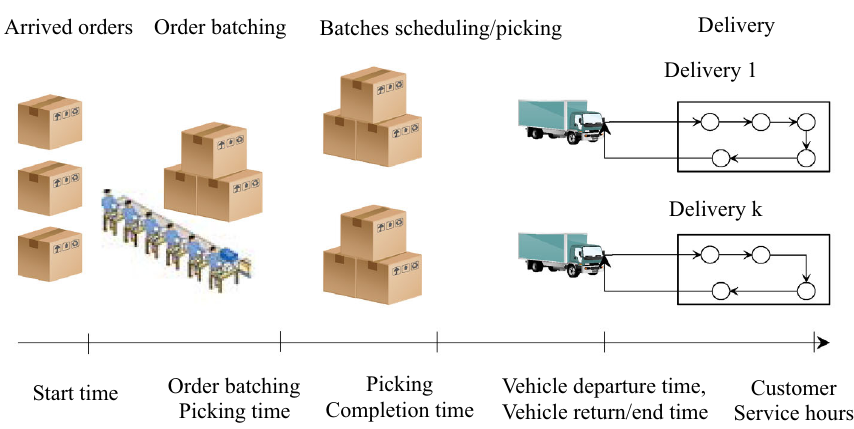
Fig. 2 Offline order distribution scheduling and path